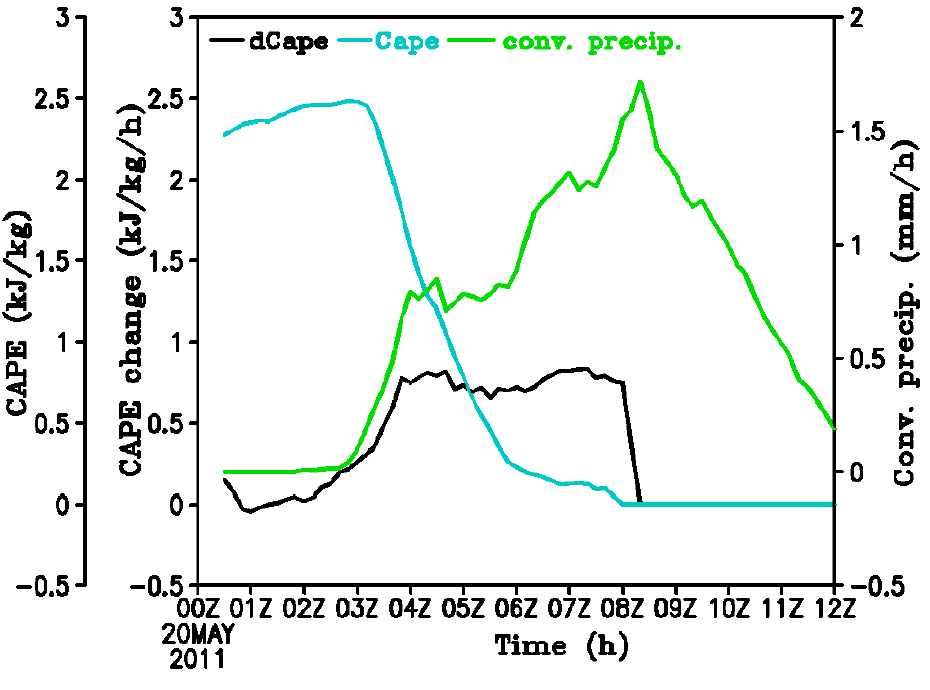
Figure 8. Time series of CAPE (kJ/kg, blue line), large-scale CAPE change (kJ/kg/h, black line), and convective precipitation rate (mm/h, green line) for 256 km subdomain.